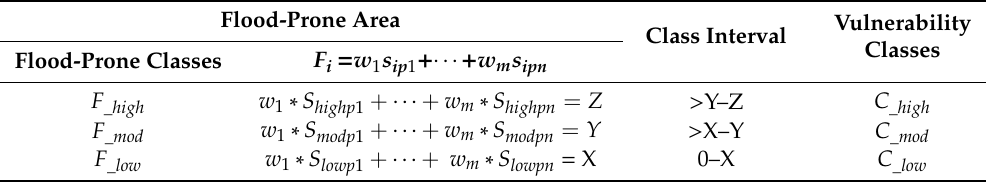
Table 2. The estimation of the vulnerability